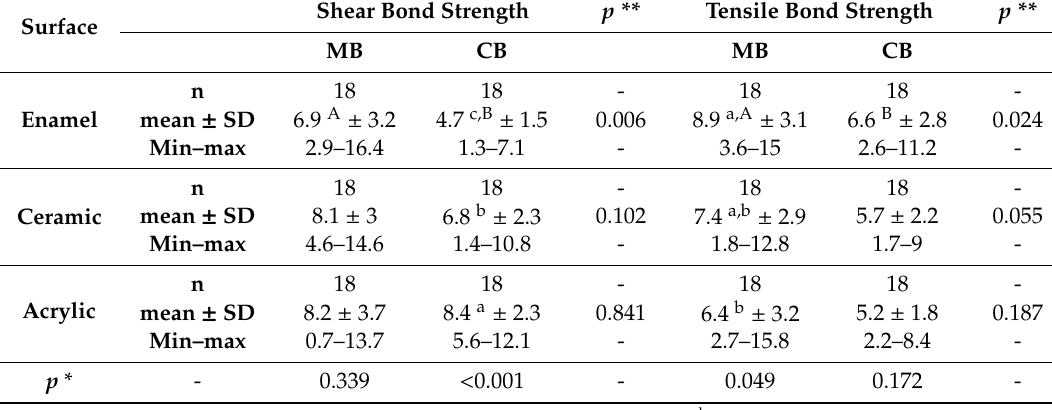
Table 2. Comparison of mean shear or tensile bond strength values (MPa) by a two-way ANOVA, surface and bracket